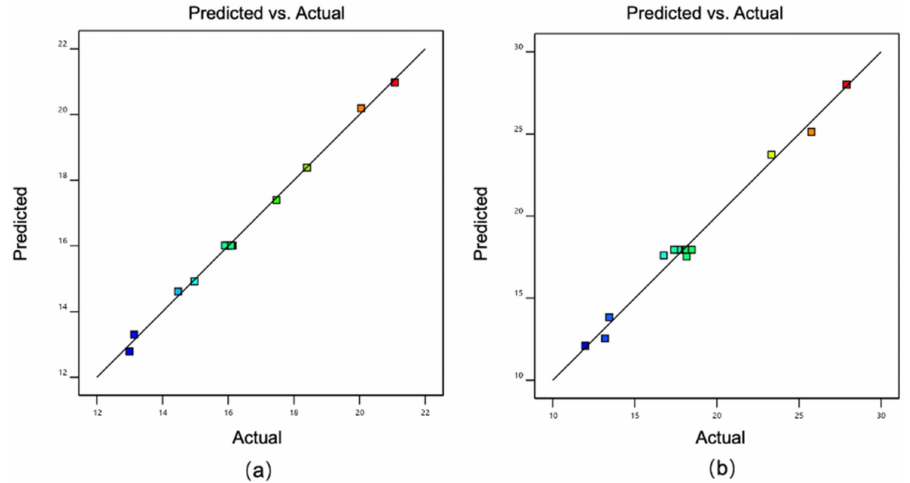
Figure 5. Actual values of DS and DC versus their predicted values ( a ): DS, ( b ):